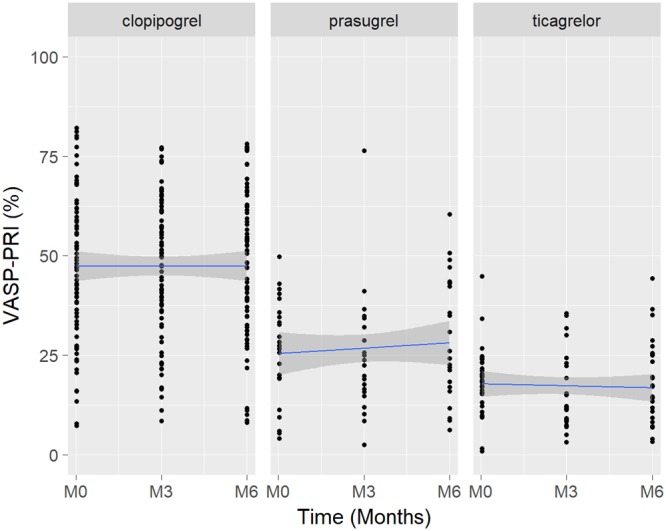
Boxplot of VASP-PRI results over time according to the anti-P2Y12 drug. VASP-PRI, vasodilator-stimulated-phosphoprotein-phosphorylation-platelet- reactivity-index.